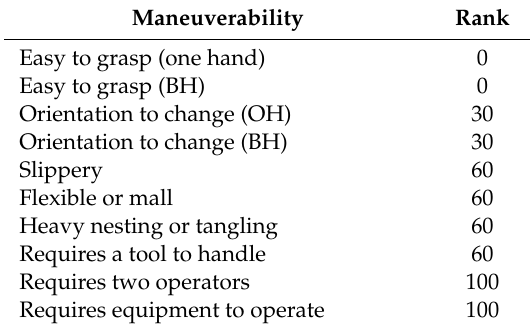
Table 8. Membership functions in tabular form of linguistic variables for maneuverability.